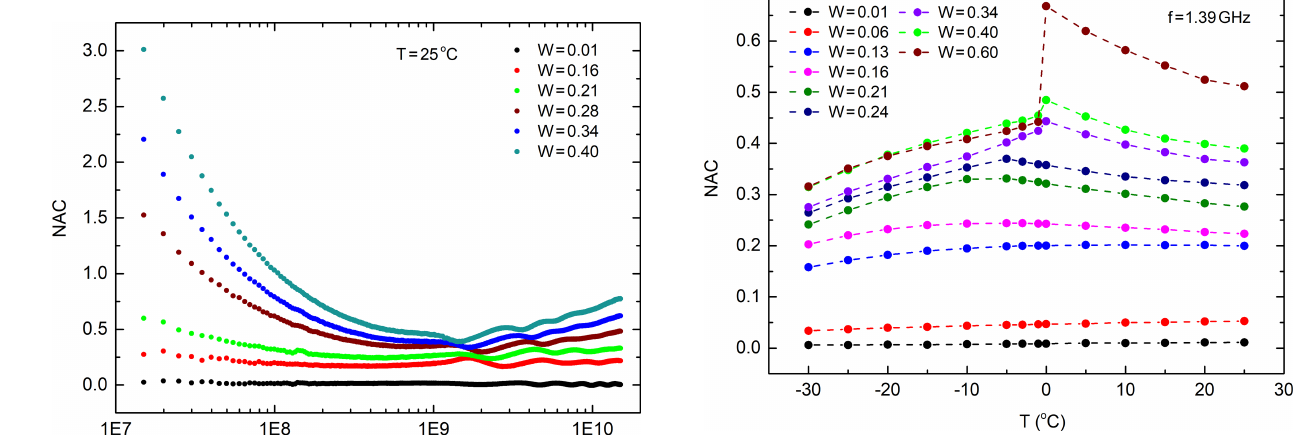
Figure 5. Normalised attenuation coefficient (NAC) for sample no. 6 (TM) depending on the temperature of the soil sample ( T ) for various moisture levels at a frequency of f =